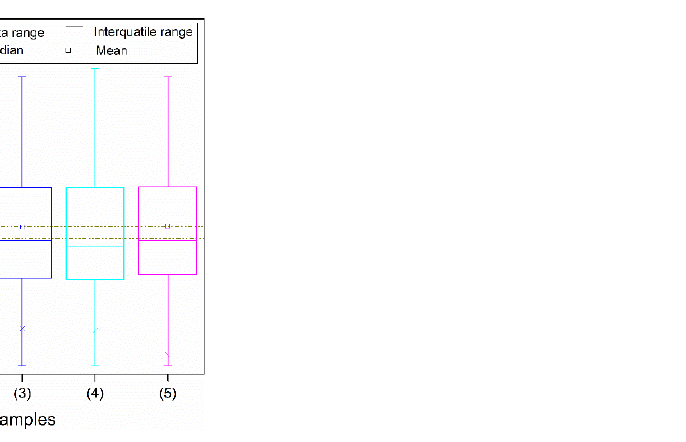
Figure 5. Statistics of the soil organic matter (SOM) content in the following samples: (1) all samples; (2) samples selected utilizing the concentration gradient (C) method; (3) samples selected utilizing the Rank–Kennard-Stone (Rank–KS) method; (4) samples selected using the Rank method; (5) samples selected utilizing the MVARC-R-KS method. Table 3. Statistical values of the spectral reflectance information in the samples.